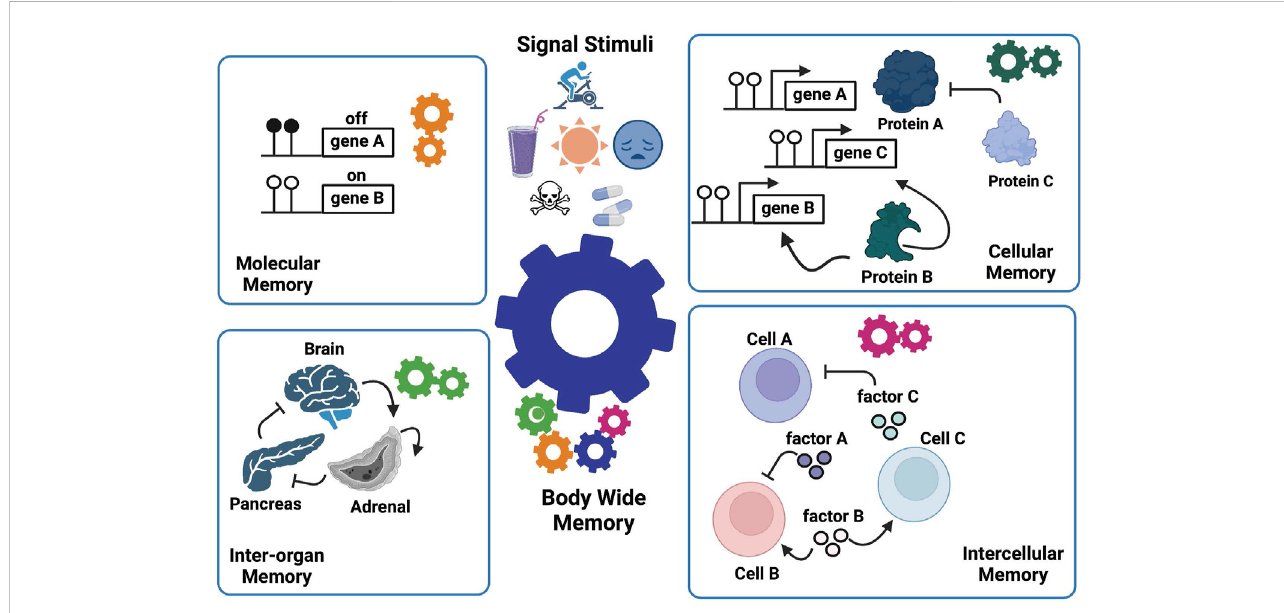
FIGURE 3 TheManifoldEpigeneticModel — MEMo.Thismodelproposesthatepigeneticbiologicmemoryisanemergentpropertyarisingfromavarietyofsystems- based interactions between different components across several biological levels (cells, tissues, and organs). The whole-body phenotypic memory (e.g., youthfulness) istheresponseto external (drugs, toxicants, environment,diet, physical activity, andmentalstress) anddevelopmental cues, and representsthe orchestrated output from molecular, cellular, intercellular, and inter-organ memories. As illustrated, the epigenetic memory relies on positive feedback loops in each biological layer to enforce persistent signals that sustain a given biological